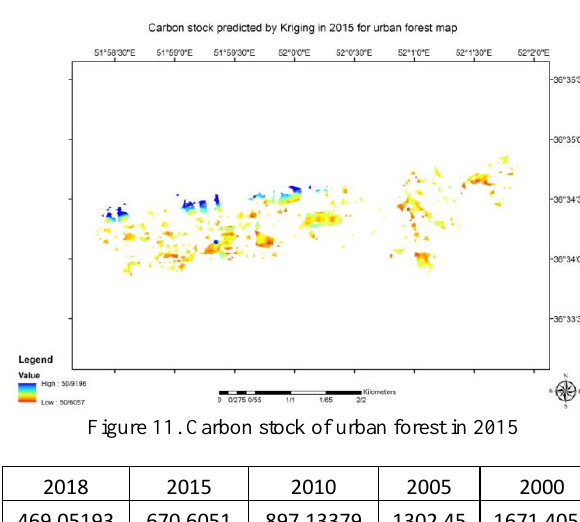
Figure 11. Carbon stock of urban forest in 2015